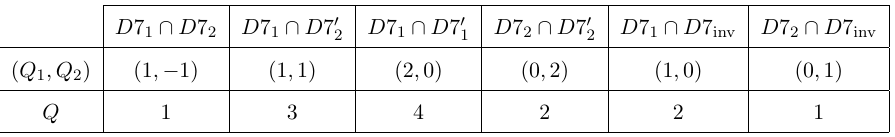
Table 2 . U(1) charges for charge 3 (I) and charge 4 (I) models in type IIB. The state at D 7 1 \ D 7 0 is present only in charge 4